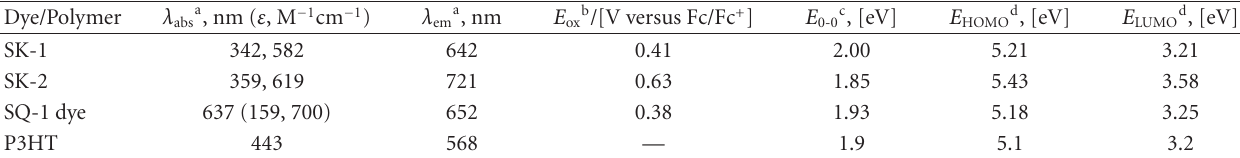
Table 1: Absorption, emission, and electrochemical properties of SQ-1, SK-1, SK-2 dyes, and P3HT polymer [7, 51]. Dye/Polymer